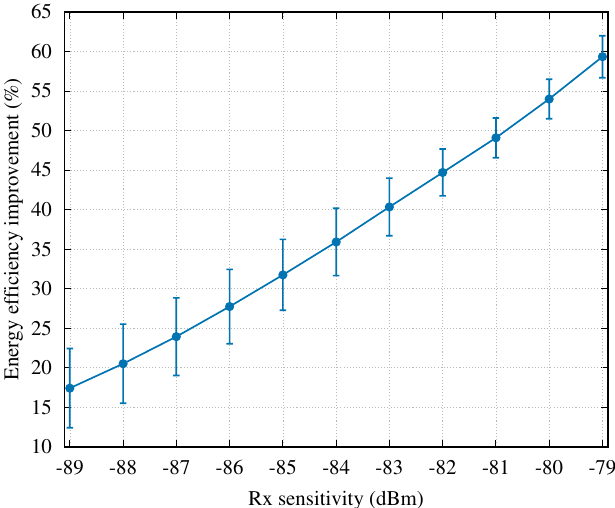
Figure 13. The energy efficiency improvement of the “AAT+non-NC” scheme over the “AAT+NC” scheme, when the Rx sensitivity